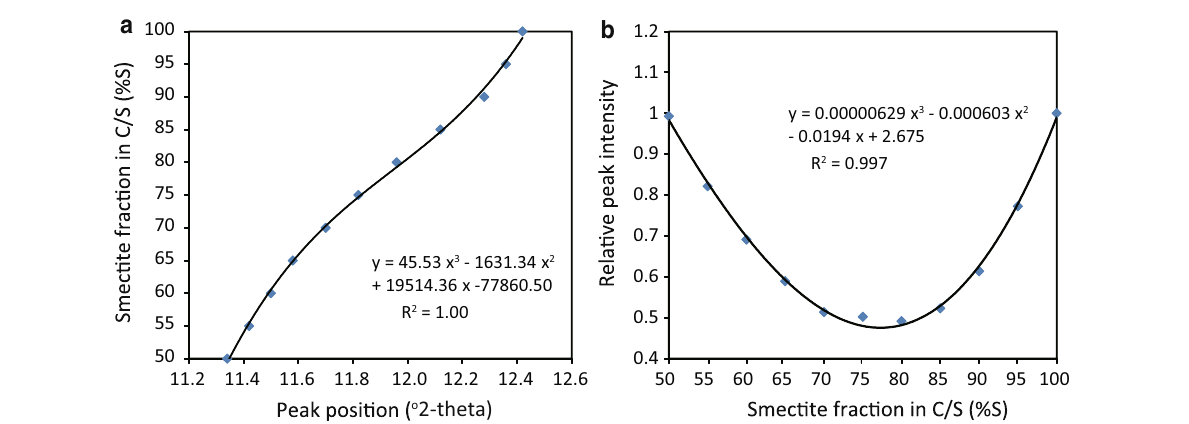
Fig. 9 Results of the NEWMOD calculations undertaken to derive polynomial expressions for the a peak position versus %S and b %S vs. relative peak intensity (RI)